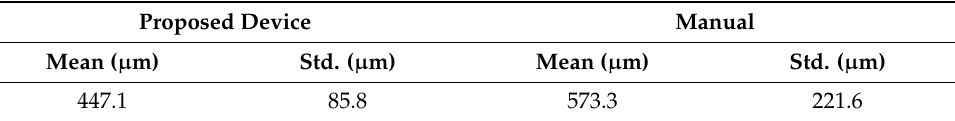
Figure 7. Box plot of the suture depth generated from the proposed device and manual suture. For each method, sixteen sutures were generated. With the device, there was one outlier (calculated with 1.5 IQR). Excluding the outlier, the median, maximum, and minimum suture depths were 477, 534, and 362 µ m. Without the device, the median, maximum, and minimum suture depths were 461.5, 1157, and 311 µ m. Table 3. Measured suture